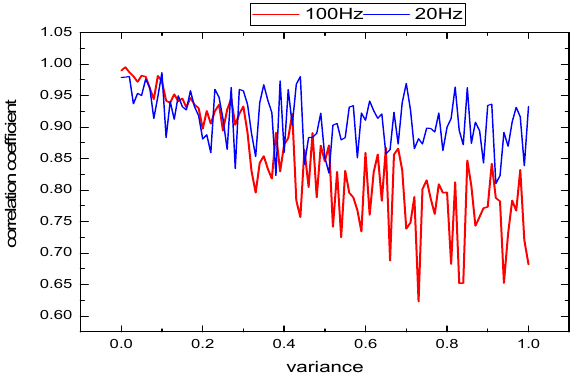
Figure 8. Correlation coe ffi cient of two components under di ff erent noise